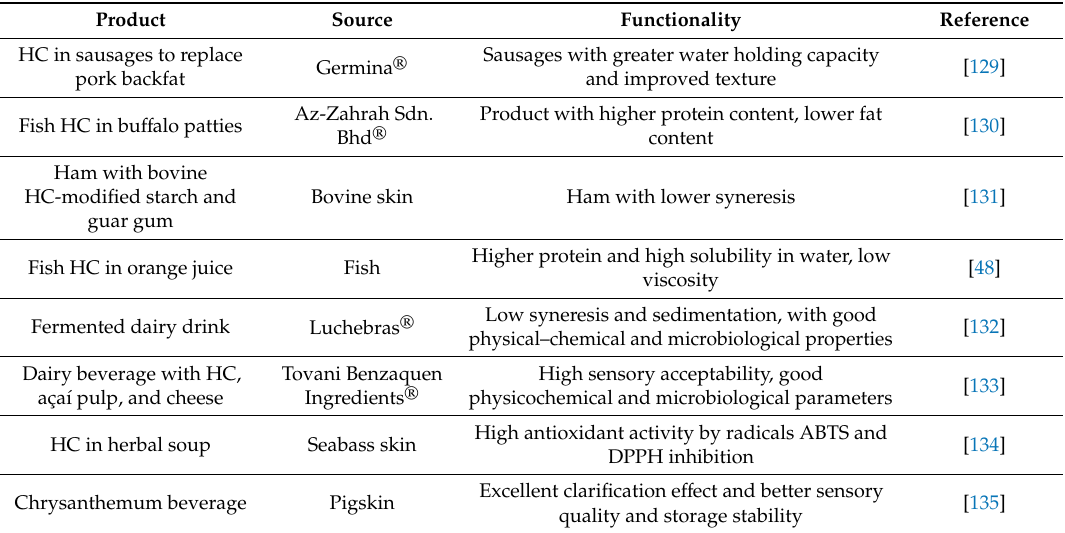
Table 3. Hydrolyzed collagen in the food